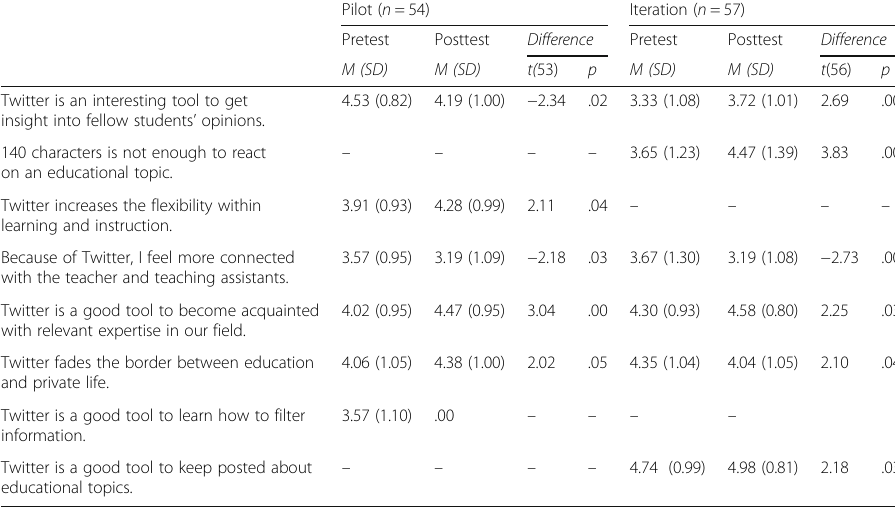
Table 3 Significant differences between students ’ expectations about and experiences with using Twitter Pilot ( n =54) Iteration ( n